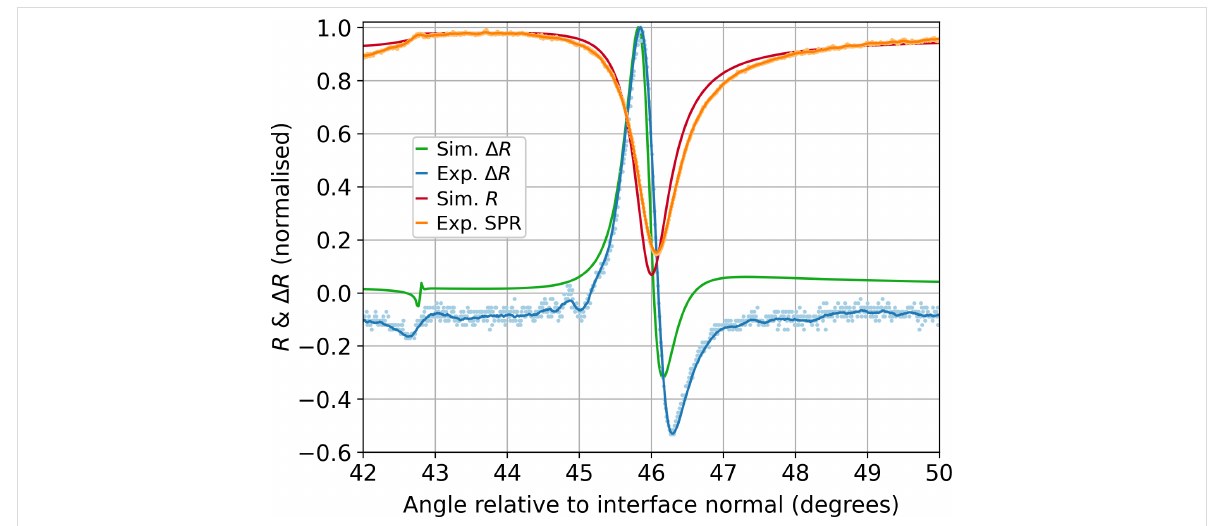
Figure 6: Plots of the enhanced SPR curves for a sapphire–silver–air configuration excited at 561 nm showing the typical shape in red and orange, and Δ R response, taken from the lock-in amplifier ( X ) component, or the effective difference between the coldest and hottest states in blue and green for a modulated 20 μ m square active element. Orange shows the experimental curve normalised to the simulation maximum for an applied (RMS) cur- rent density of 71 mA/ μ m 2 . The angular position of the TIR response of the experimental SPR curves has been calibrated to the simulation. The solid lines are a centred moving average for each experimental curve. Experimental errors are considered below in Figure 8. The results of COMSOL 2D optical simulations were computed for a system at room temperature and with a temperature distribution extracted from thermal simulations. The curves presented are the average between those two states (red) and their difference (green).